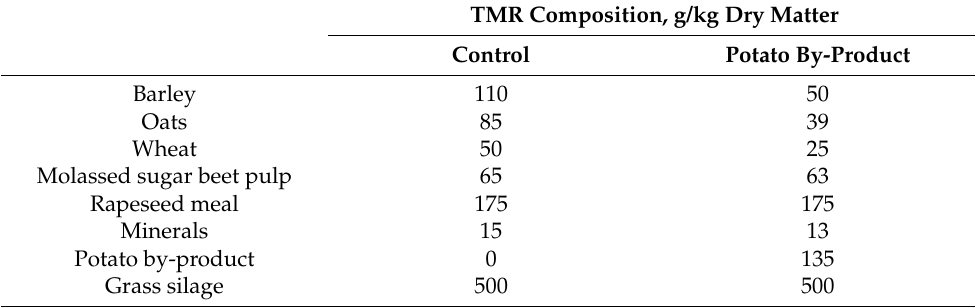
Table 1. Composition of the total mixed rations (TMR) in the dairy cow feeding experiment (Experi- ment